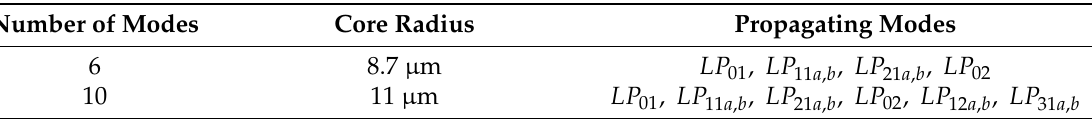
Table 1. Graded-index-few-mode fibers (GI-FMF) parameters for 6- and 10-mode fibers with NA = 0.205. Number of